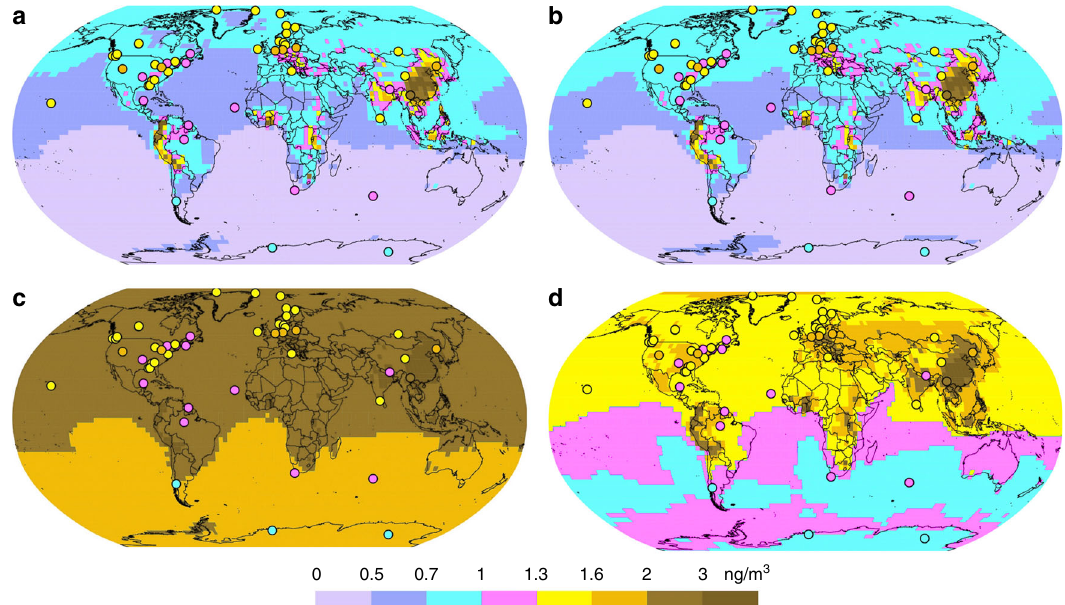
Fig. 6 Spatial distribution of Hg(0) surface concentration for different atmospheric Hg(II) reduction simulations in the GLEMOS model: a Run #1; b Run #2; c Run #3; d Run #4. Circles show observed values in the same colour scale. The measurement dataset is the same as in ref. 35